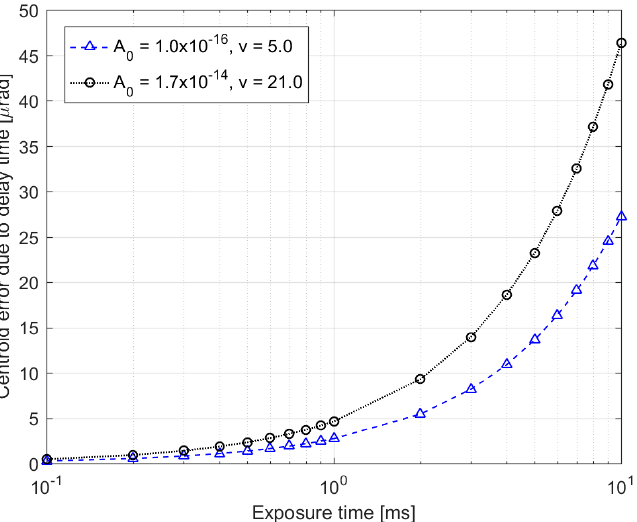
Figure 4. Centroid error due to delay time (i.e., exposure time in the simulation) versus exposure time under two atmospheric turbulence conditions.